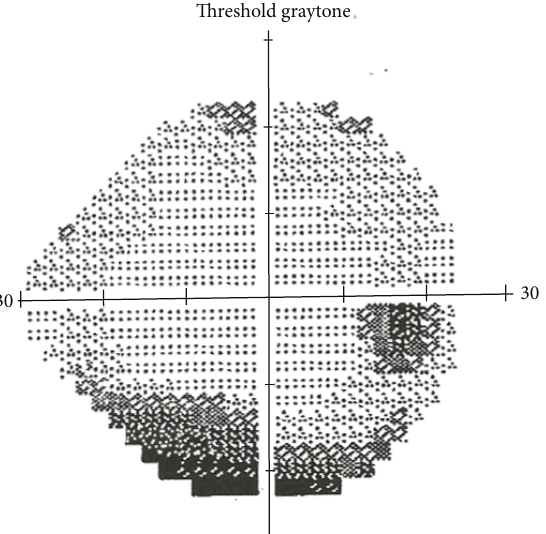
Figure 2: The follow-up perimetry visual field test after six- week doxycycline treatment demonstrated improvements of arcuate scotoma, superior vertical step, and inferior partial arcuate